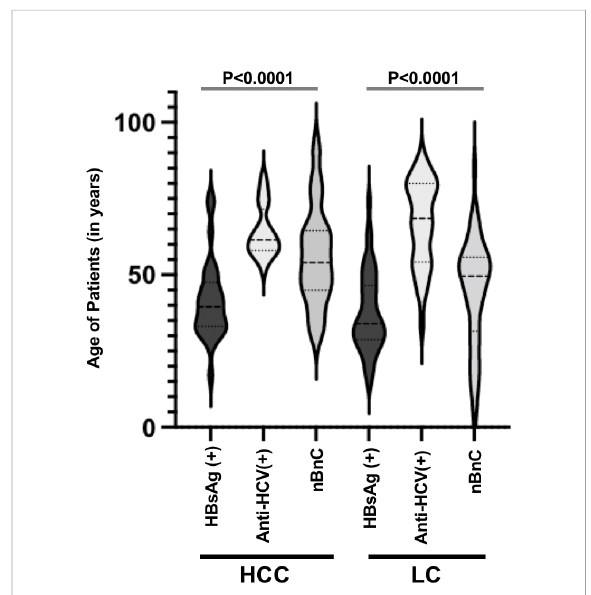
FIGURE 3 Age of patients in HCC and LC according to the main